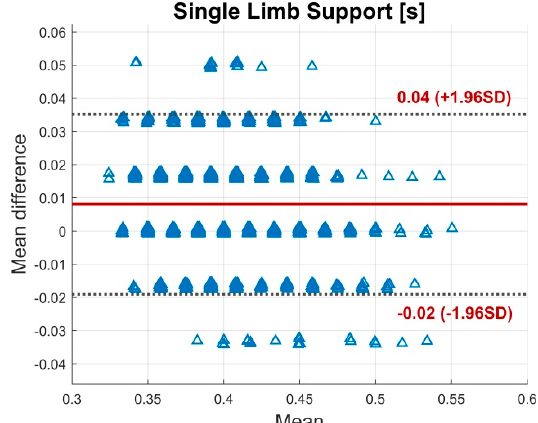
Figure A3. BA plot for the single limb support. The plot contains all calculated data points of all subjects. The solid line indicates the mean difference. The dashed lines indicate the LoA (95% CI of the mean difference).